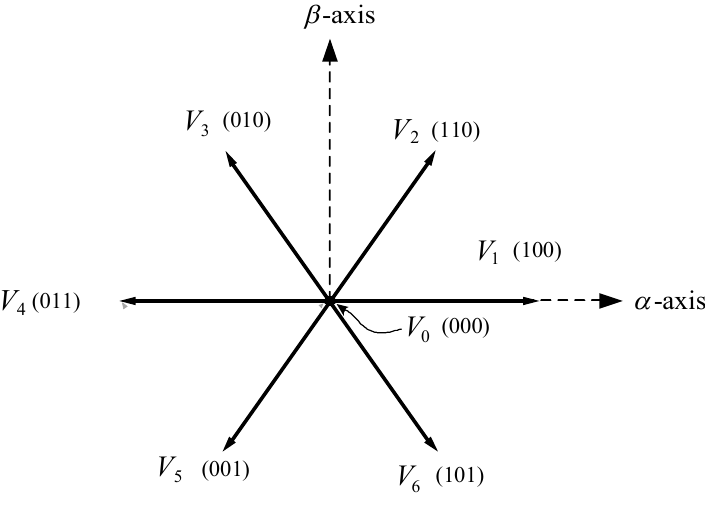
Figure 2. Seven voltage vectors.